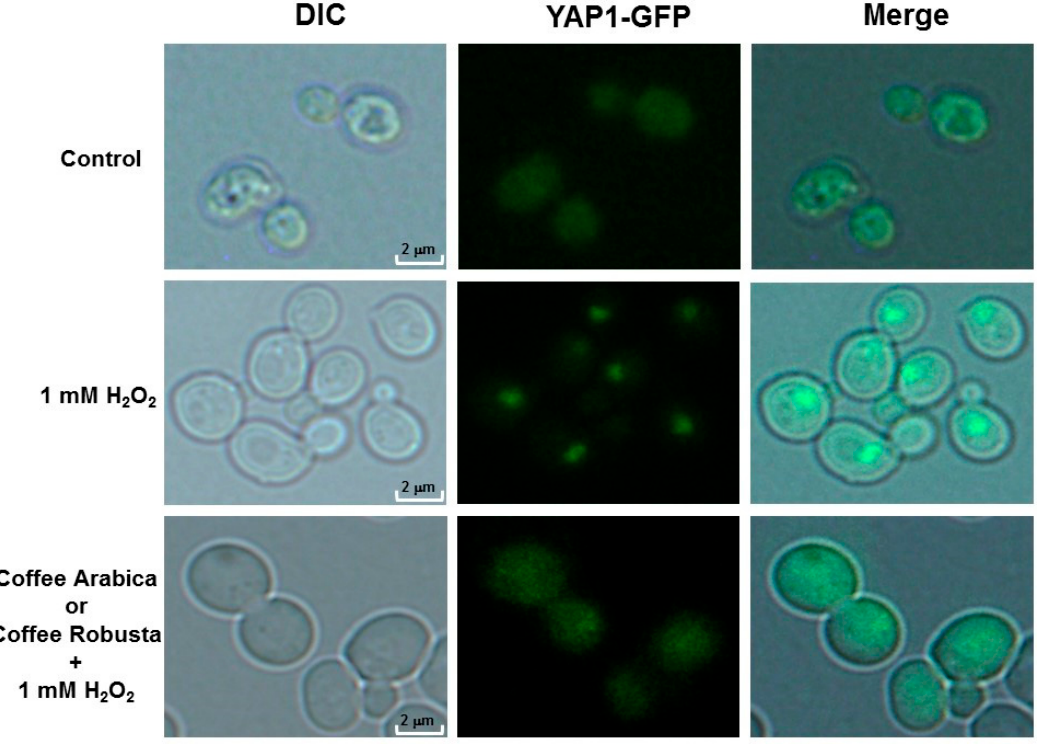
Figure 4. Coffee infusions protect by Yap1-GFP nuclear localization during oxidative stress inducing by hydrogen peroxide. Control—cells from the Yeast Extract–Peptone–Dextrose (YPD) culture and 1 mM H 2 O 2 —cells incubated for 1 h with hydrogen peroxide in the YPD medium. Yap1-GFP fusion protein can be seen to concentrate in the nuclei and coffee + H 2 O 2 —cells incubated for 3 h with coffee, centrifuged and hanging in fresh medium, and treated with hydrogen peroxide for 1 h. Representative results from three independent experiments are shown. Fluorescence pictures were taken with an Olympus BX-51 microscope equipped with a DP-72 digital camera and cellSens Dimension software (1000× magnification).